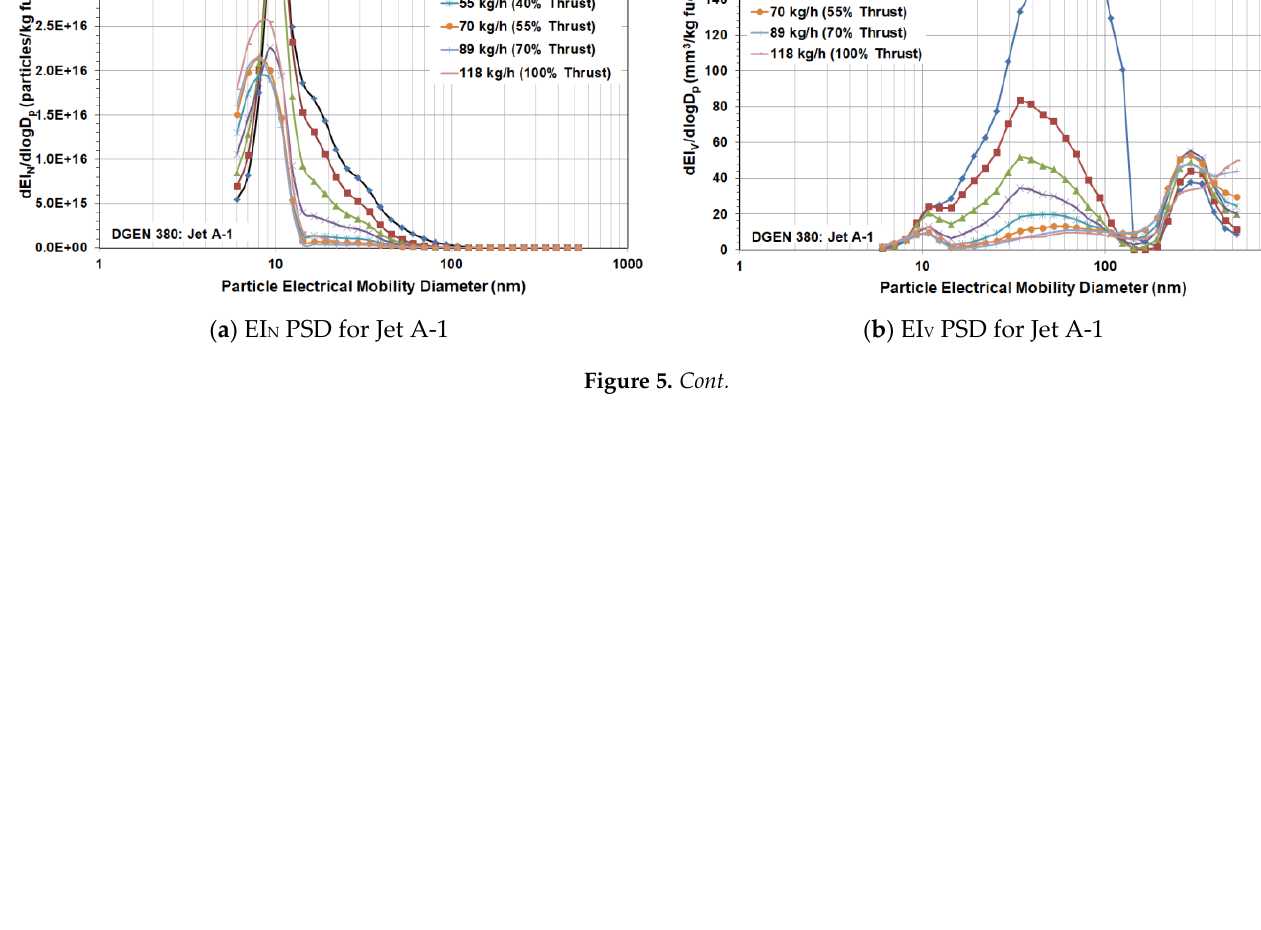
Figure 4. PM mass emission index (EI M ) versus DGEN 380 fuel flow. Error bars represent one standard deviation.